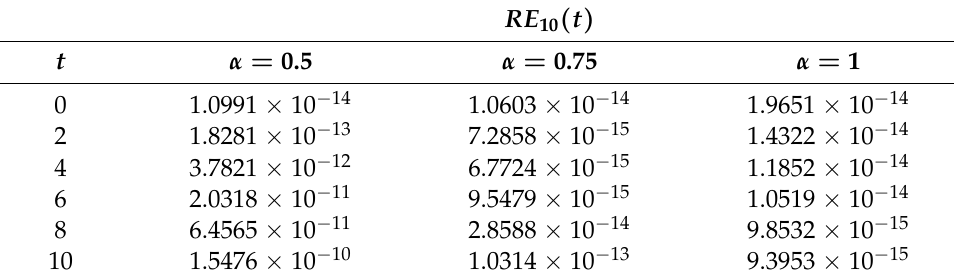
Table 2. The residual error RE 10 ( t ) when λ = 1 and q = 2 at three different values of α .